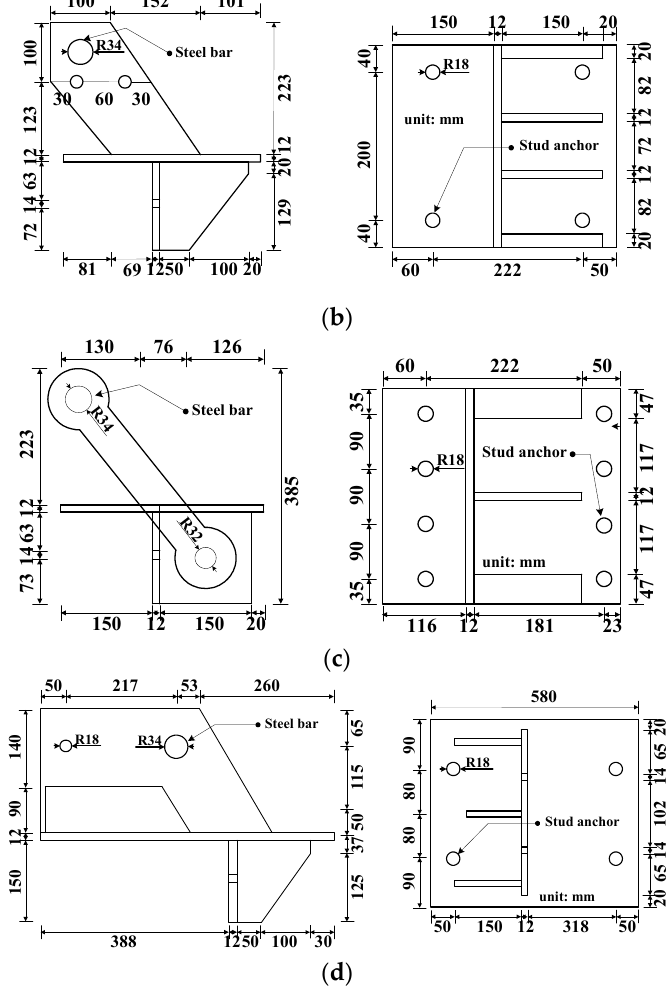
Figure 2. Anchorages. ( a ) LHS; ( b ) LHT; ( c ) LHU and ( d ) JBM.